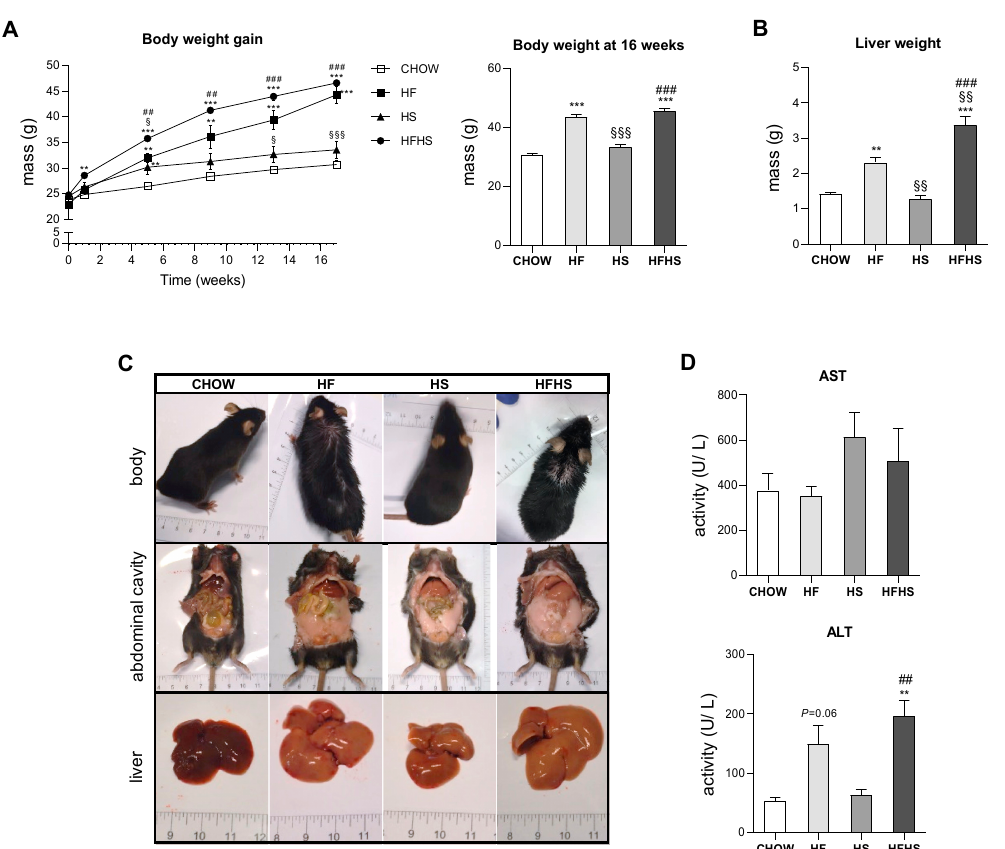
Figure 1. HFHS diet causes body and liver weight gain and increases ALT levels. ( A ) Body weight gain profile during the 16-week feeding period (left panel) and body weight at the end of the feeding period (right panel) ( N = 18). ( B ) Liver weight at the end of the feeding period ( N = 4). ( C ) Representative images of body, abdominal cavity and liver appearance at the end of the feeding period. ( D ) Plasma AST and ALT levels ( N = 4). All data are expressed as the mean ± SEM. (§) vs. the HF diet ( P < 0.05); (**) vs. the CHOW diet, (§§) vs. the HF diet and (##) vs. the HS diet ( P < 0.01); (***) vs. the CHOW diet, (§§§) vs. the HF diet and (###) vs. the HS diet ( P < 0.001); P values were determined using one-way ANOVA followed by Bonferroni’s post hoc test. HF, high-fat; HS, high-sucrose; HFHS, high-fat plus high-sucrose; AST, aspartate aminotransferase; ALT, alanine aminotransferase.